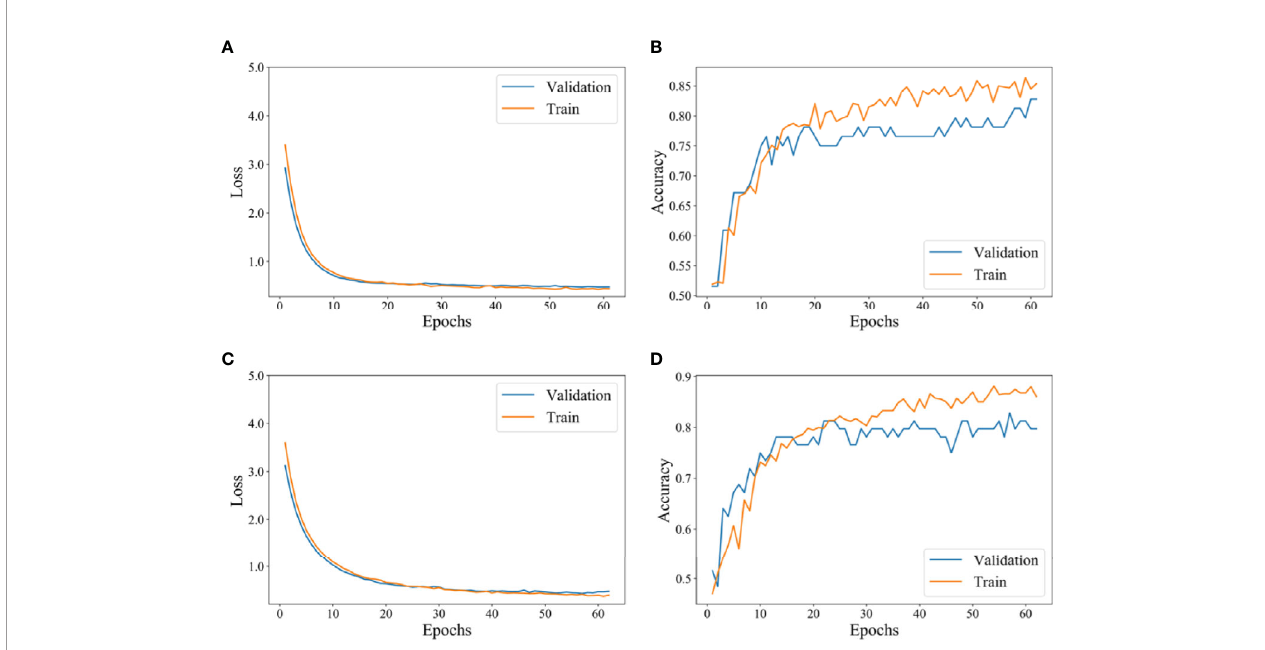
FIGURE 4 | The training process of the deep learning model. (A) Loss curve of SE-CNN with epoch. (B) Accuracy curve of SE-CNN with epoch. (C) Loss curve of CNN with epoch. (D) Accuracy curve of CNN with epoch.